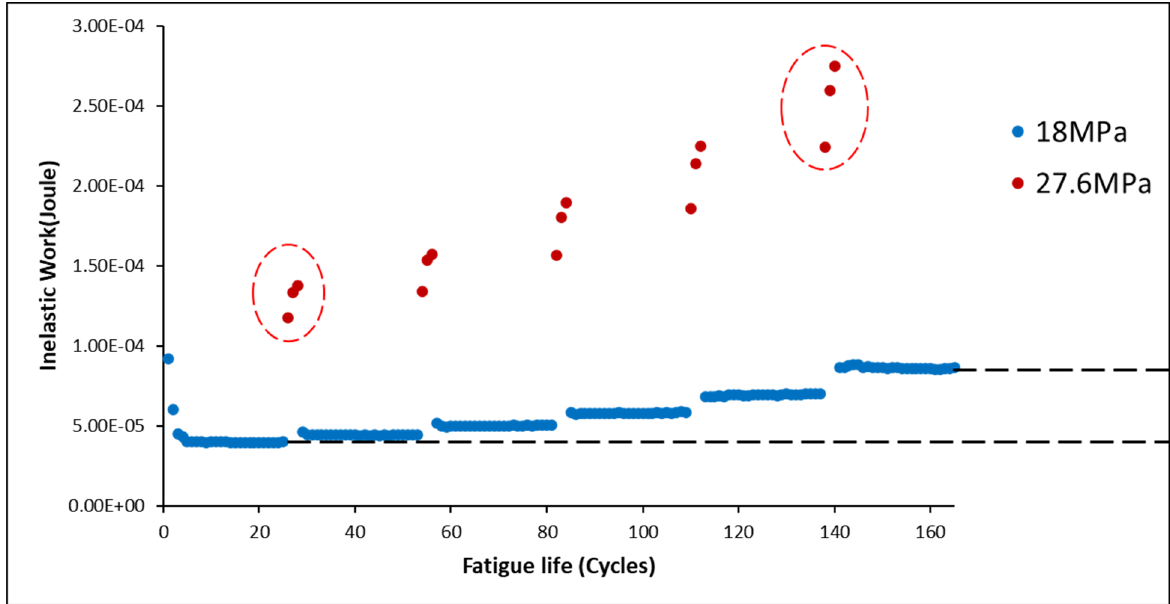
Figure 9. Inelastic work of non-aged SAC305 individual soler joint in varying stress amplitude test (18 MPa–27.6 MPa).